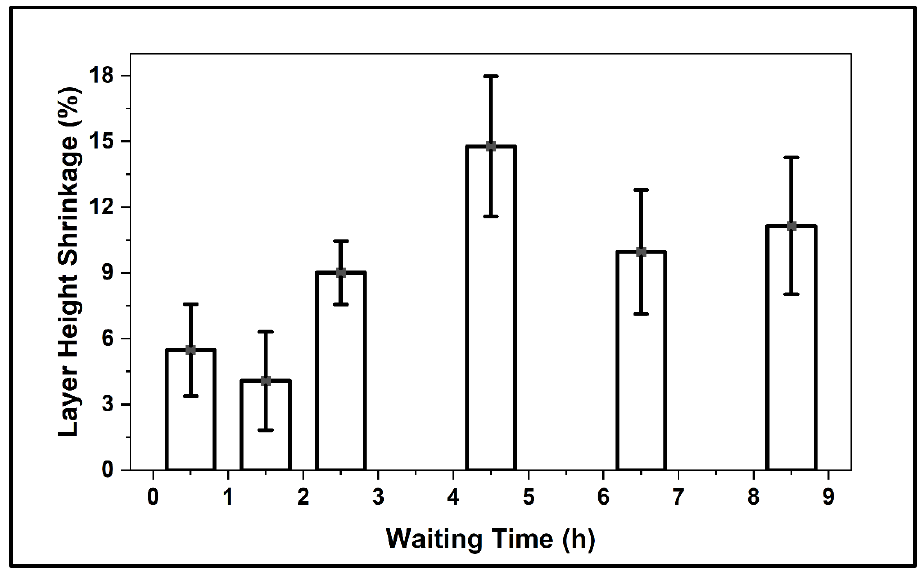
Figure 14. Effects of waiting time on layer-height shrinkage.